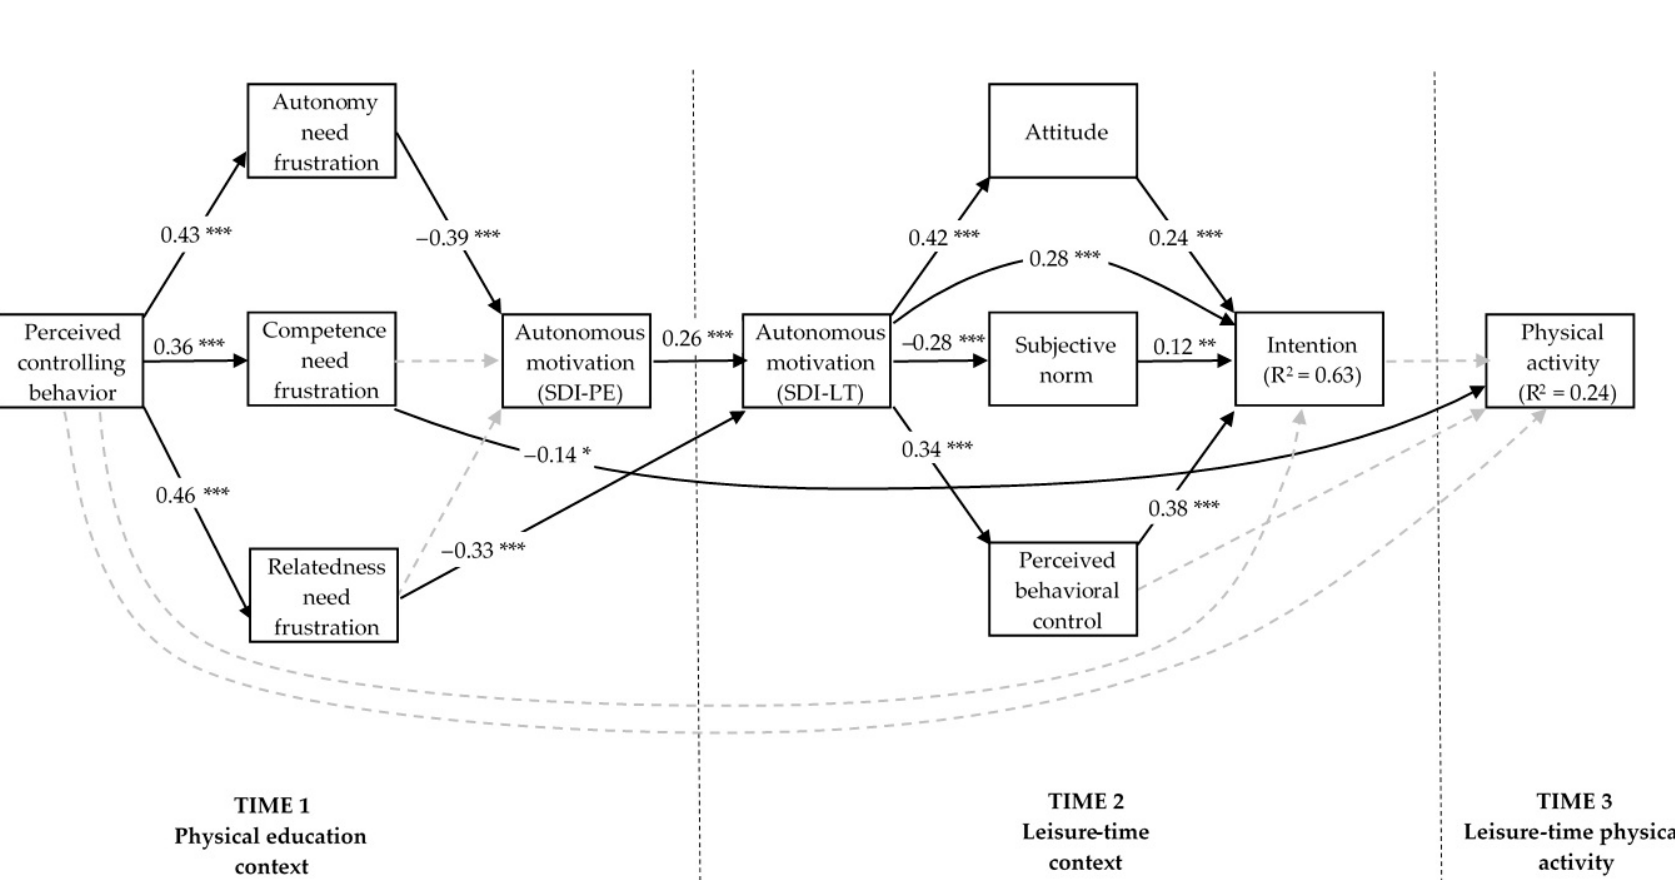
Figure 2. Standardized path estimates for the hypothesized relations among the trans-contextual models. The faint broken lines are indicative of nonsignificant paths. The following parameters have been omitted from the figure for clarity reasons: (i) direct paths from past physical activity behavior on all study variables; (ii) error covariances between the psychological need frustration; and (iii) error covariances between attitude, subjective norms, and perceived behavioral control. Past physical activity had significant direct effects on autonomy need frustration ( − 0.12 *), competence need frustration ( − 0.19 ***), SDI-PE (0.19 ***), SDI-LT (0.34 ***), attitude (0.17 **), subjective norms (0.23 ***), perceived behavioral control (0.30 ***), and physical activity behavior (0.42 ***). SDI-PE = self-determination index in a physical education context; SDI-LT = self-determination index in a leisure-time context. * p < 0.05; ** p < 0.01; *** p < 0.001.